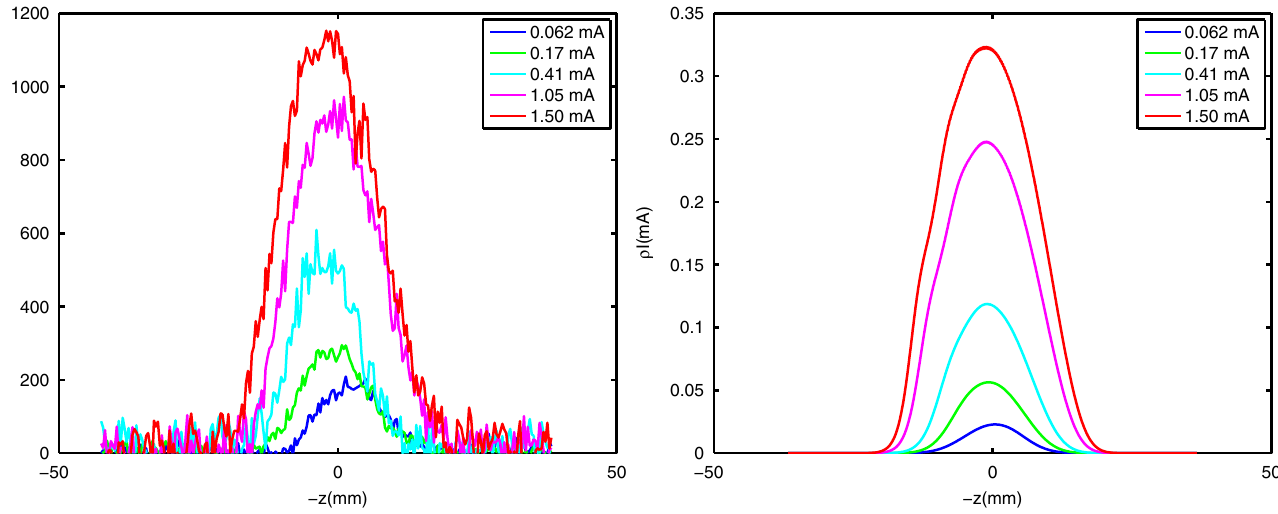
FIG. 3. (Color) Comparisons of bunch profiles of the measurement using a streak camera and products of the Haissinski distributions and the corresponding beam currents.